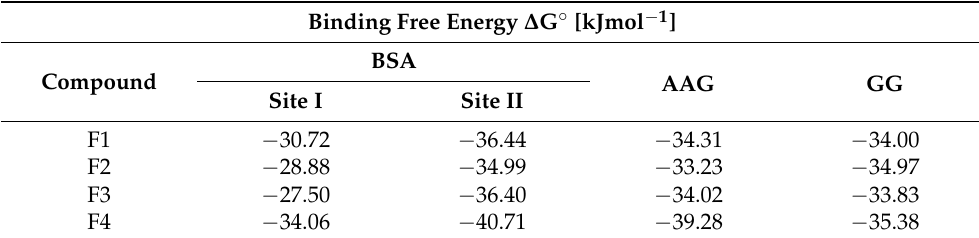
Table 6. Binding Free Energy ∆ G ◦ complexes F1–F4 with BSA, AAG, and